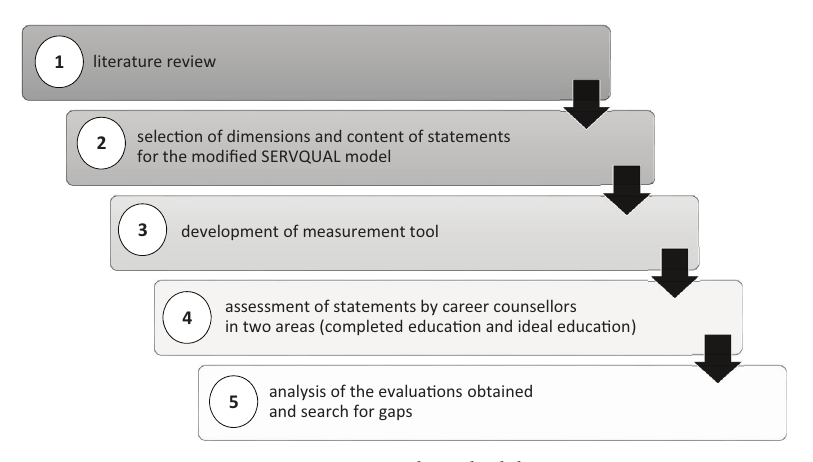
Figure 4. Research